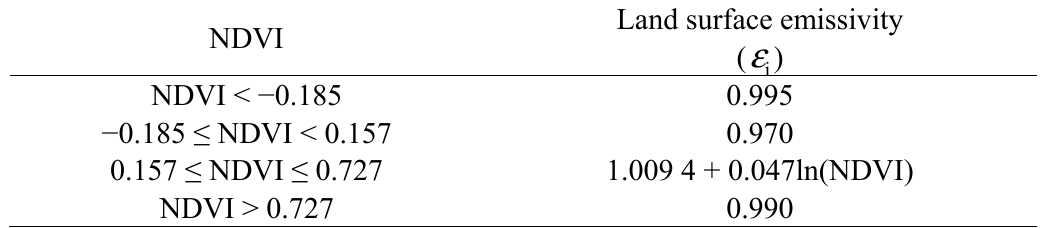
Table 3. Estimation of emissivity using